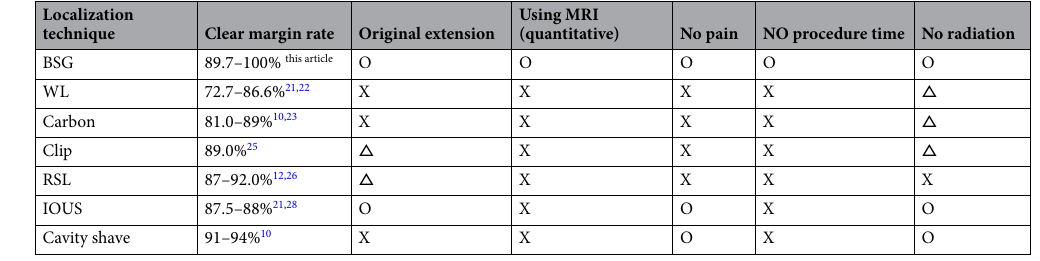
Table 3. Localization techniques in patients who underwent neoadjuvant systemic therapy (NST). BSG breast surgical guide, WL wire localization, Carbon carbon marking, Clip clip marker localization, RSL radioactive seed localization, IOUS intraoperative ultrasound excision, Time procedure